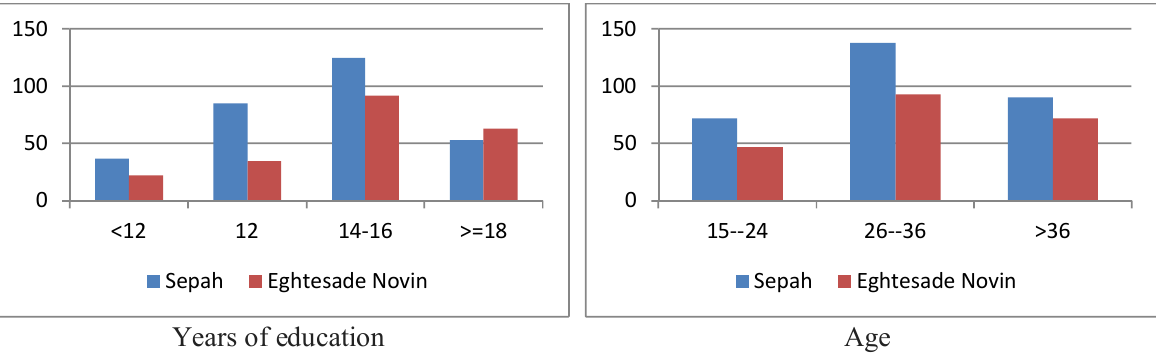
Fig. 1. Personal characteristics of the